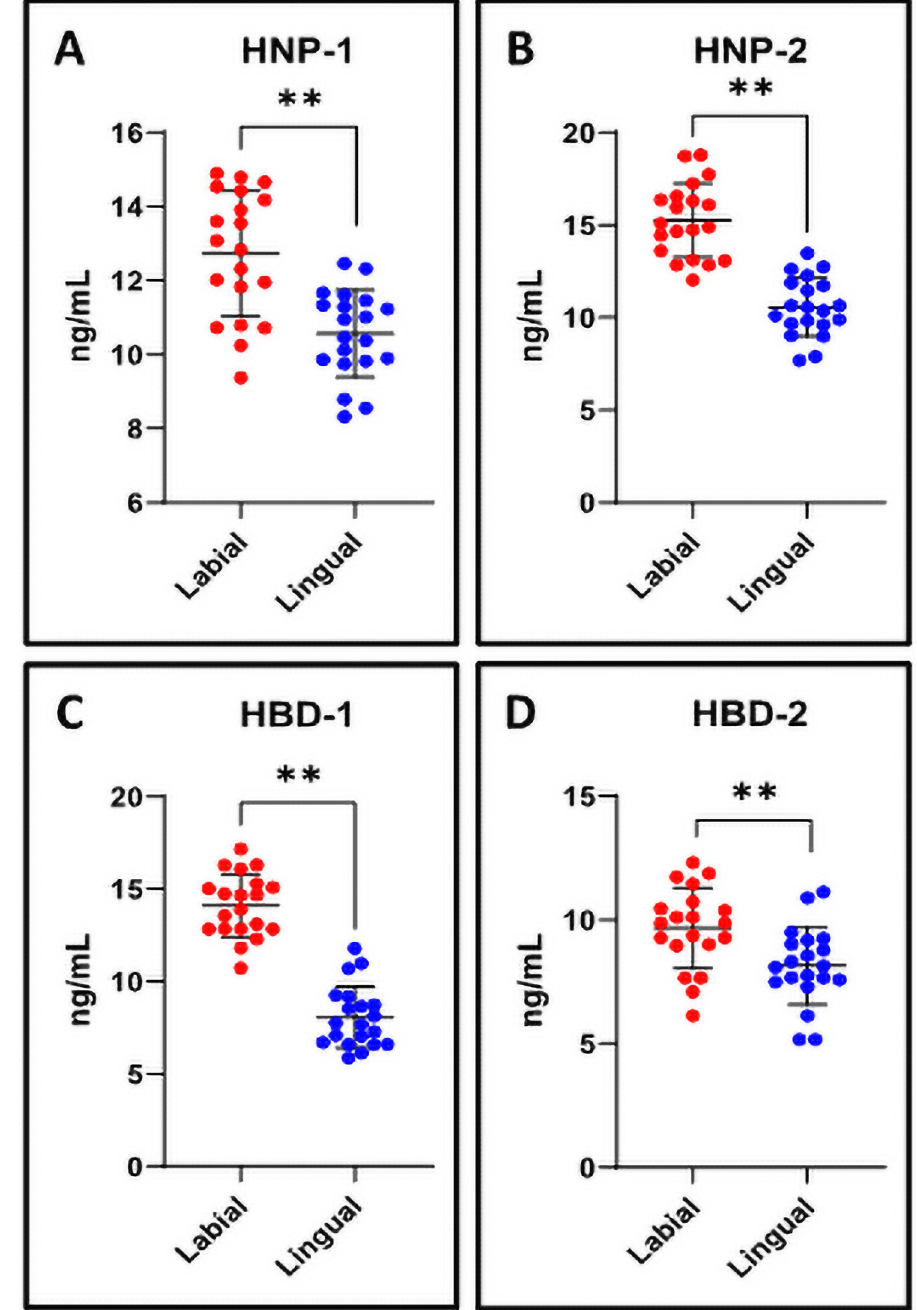
Fig 3. ELISA assay for analysis of human defensins in the saliva. (A-D) The quantitation and comparative analysis of human defensins in the salivary samples was assessed by ELISA on spectrophotometer. n.s. not significant, � p < 0.05, �� p < 0.001. HNP-1: Human alpha defensin 1, HNP-2: Human neutrophil peptide 2, HBD-1: Human beta-defensin 1, HBD-2: Human beta-defensin-2.